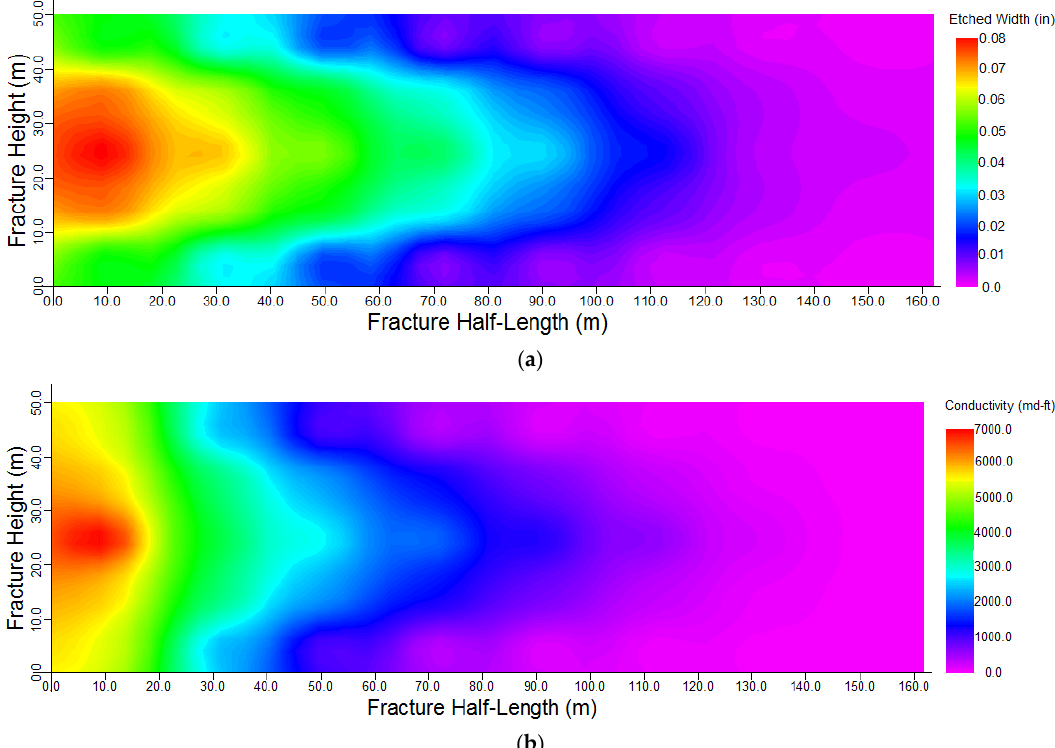
Figure 5. Acid-etched width ( a ) and fracture conductivity ( b ) distribution in the fracture domain for a flow rate of 10 bbl/min and 400 bbl acid volume.